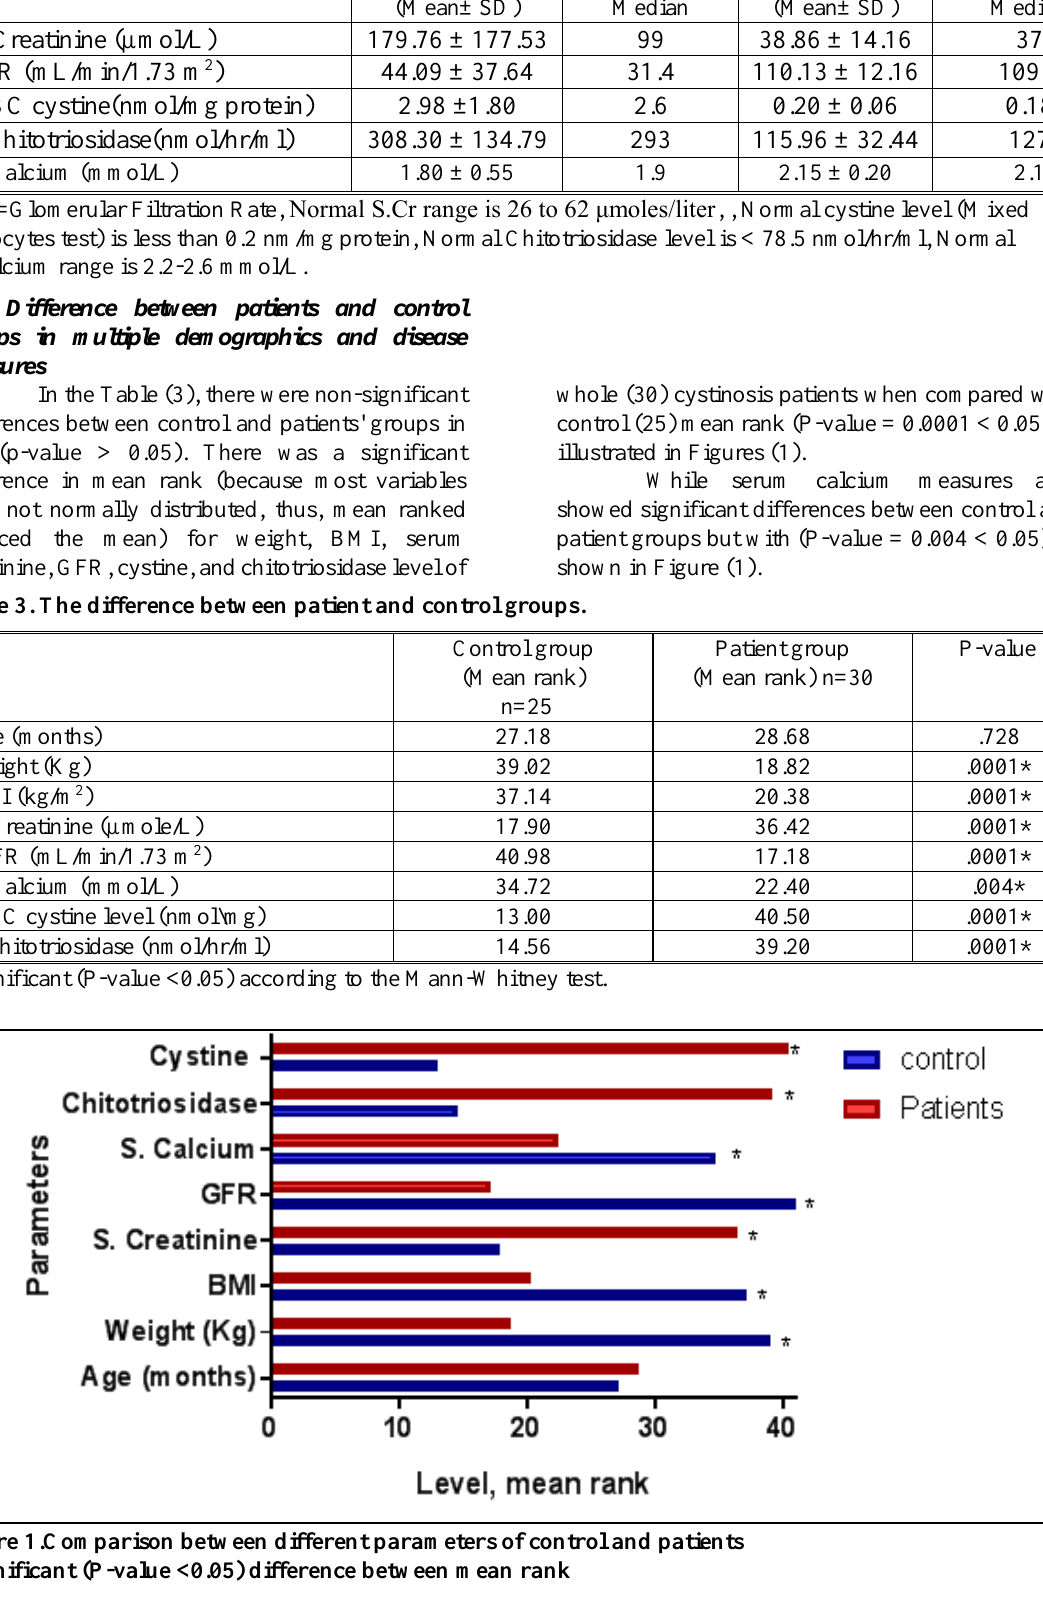
Table 2. Studied biomarkers among patients and control